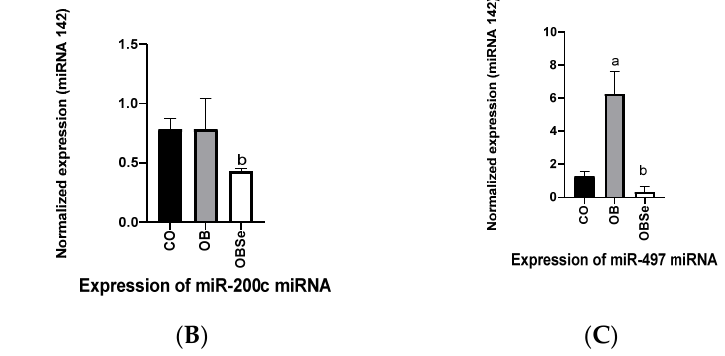
Figure 6. Effect of high-fat obesogenic diet and Se supplementation on sperm miRNA levels: ( A ) miR-15b; ( B ) miR-200c; ( C ) miR-497. Data represent the mean ± SEM ( n = 7/group). Statistically significant difference ( p ≤ 0.05) compared to a CO and b OB groups according to one-way ANOVA, followed by Tukey’s multiple comparisons test. Tendency of Statistically significant dif- ference ( p ≤ 0.07) compared to c CO according to one-way ANOVA, followed by Tukey’s multiple comparisons